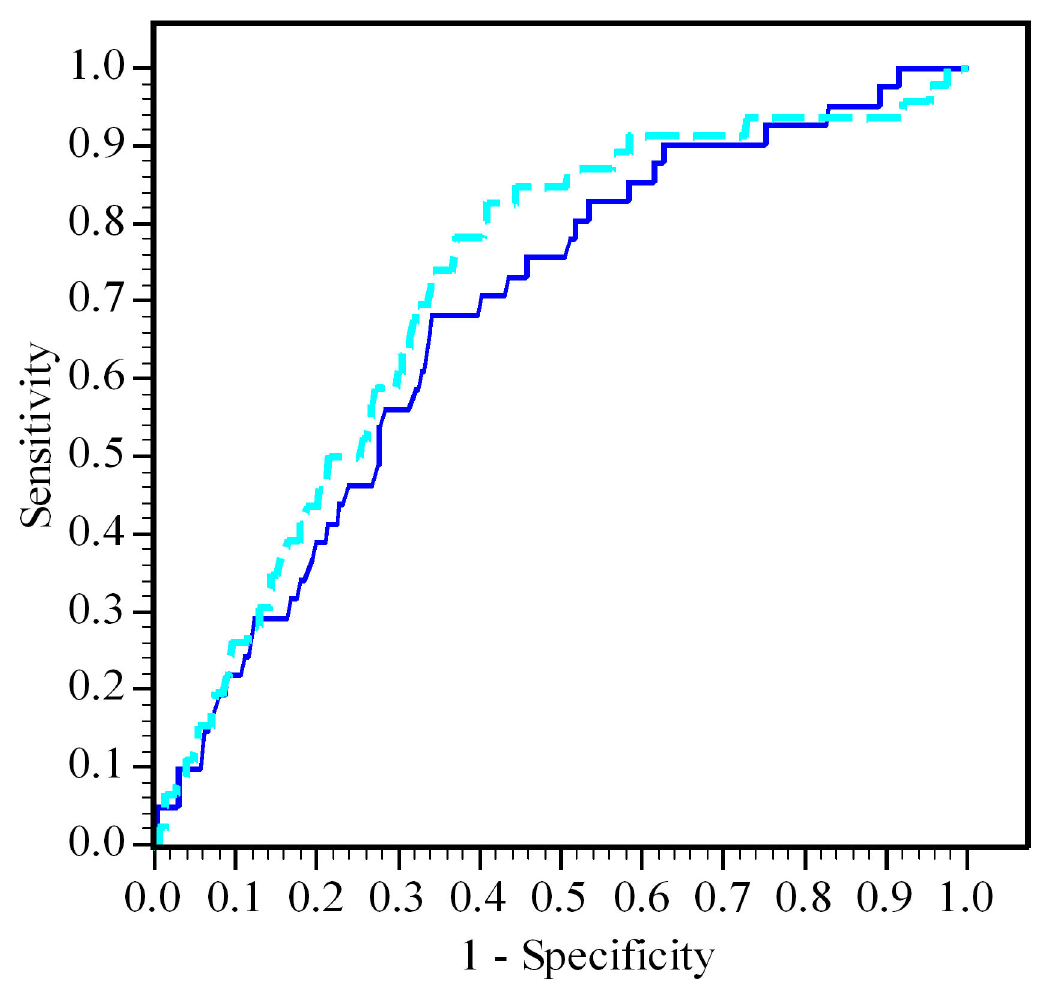
Figure 2. Receiver operating characteristic curves of risk indices in predicting the incidence of OMJ. Areas under the curve are 0.683 (95% confidence interval, 0.607 to 0.760) for the solid curve among oral BPs users and 0.718 (0.648 to 0.789) for the dashed curve in all patients.